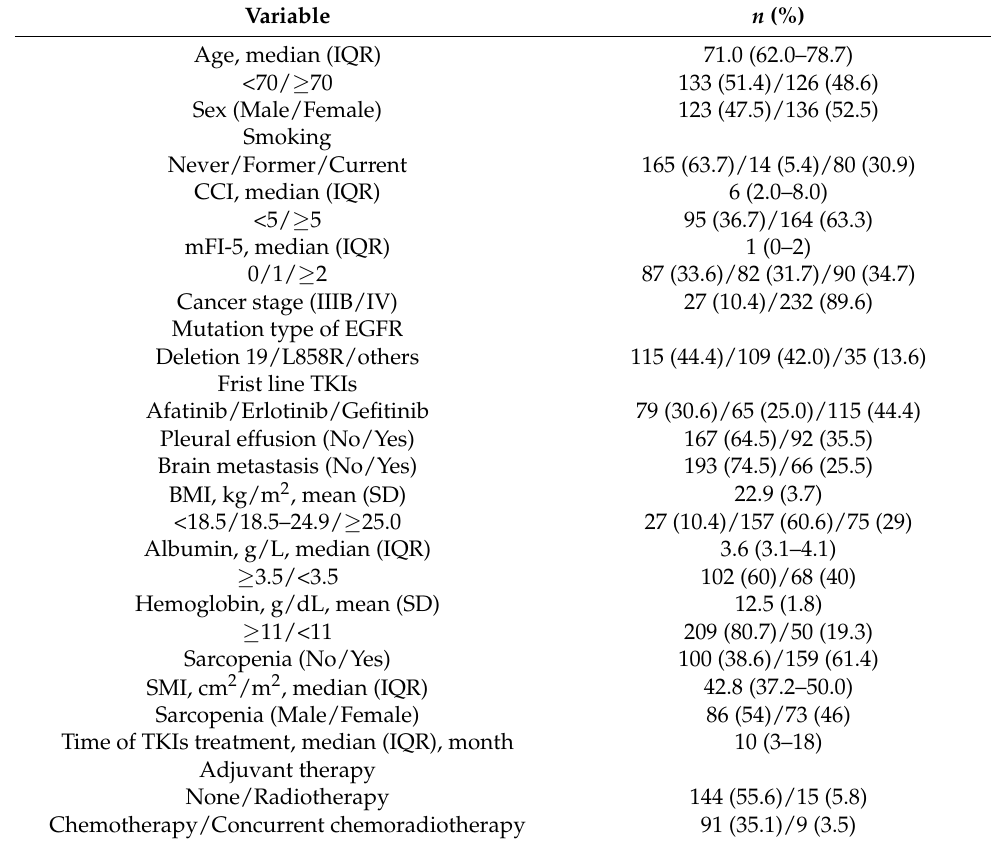
BMI: body mass index; CCI: Charlson comorbidity index; EGFR: epidermal growth factor receptor; LMR: lymphocyte-to-monocyte ratio; IQR: interquartile range; mFI-5: five-item modified frailty index; NLR: neutrophil- to-lymphocyte ratio; PLR: platelet-to-lymphocyte ratio; SD: standard deviation; SII: systemic immune inflamma- tion index; SMI: skeletal muscle index; TKIs: tyrosine kinase